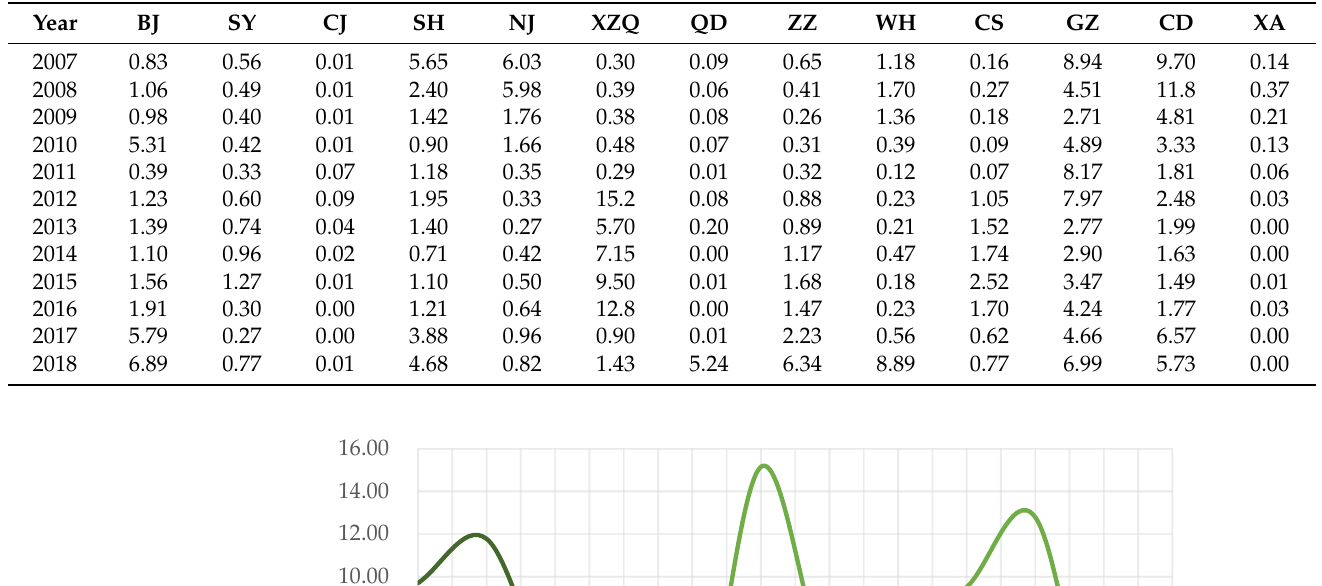
Table 5. Variance indexes of the ECILUs in the metropolitan areas from 2007 to 2018.